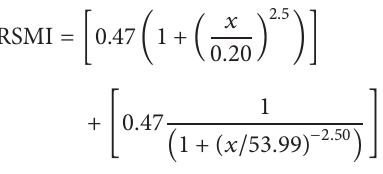
EC: electrical conductivity; SOC: soil organic carbon; TN: total nitrogen, MBC: microbial biomass carbon; MBN: microbial biomass nitrogen. Extraction method: principal component analysis. Four components